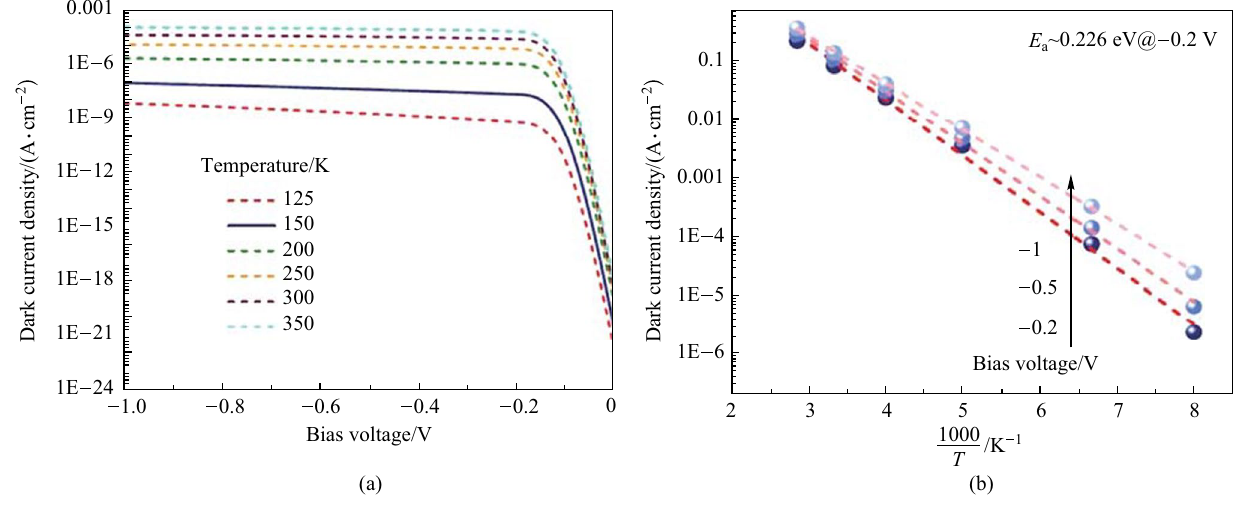
Fig. 4 Dark current of δ-DCGB nBn-PD device. a Dark current density vs. bias voltage. b Arrhenius plot of the dark current density under various applied bias voltages at temperatures from 125 to 350 K